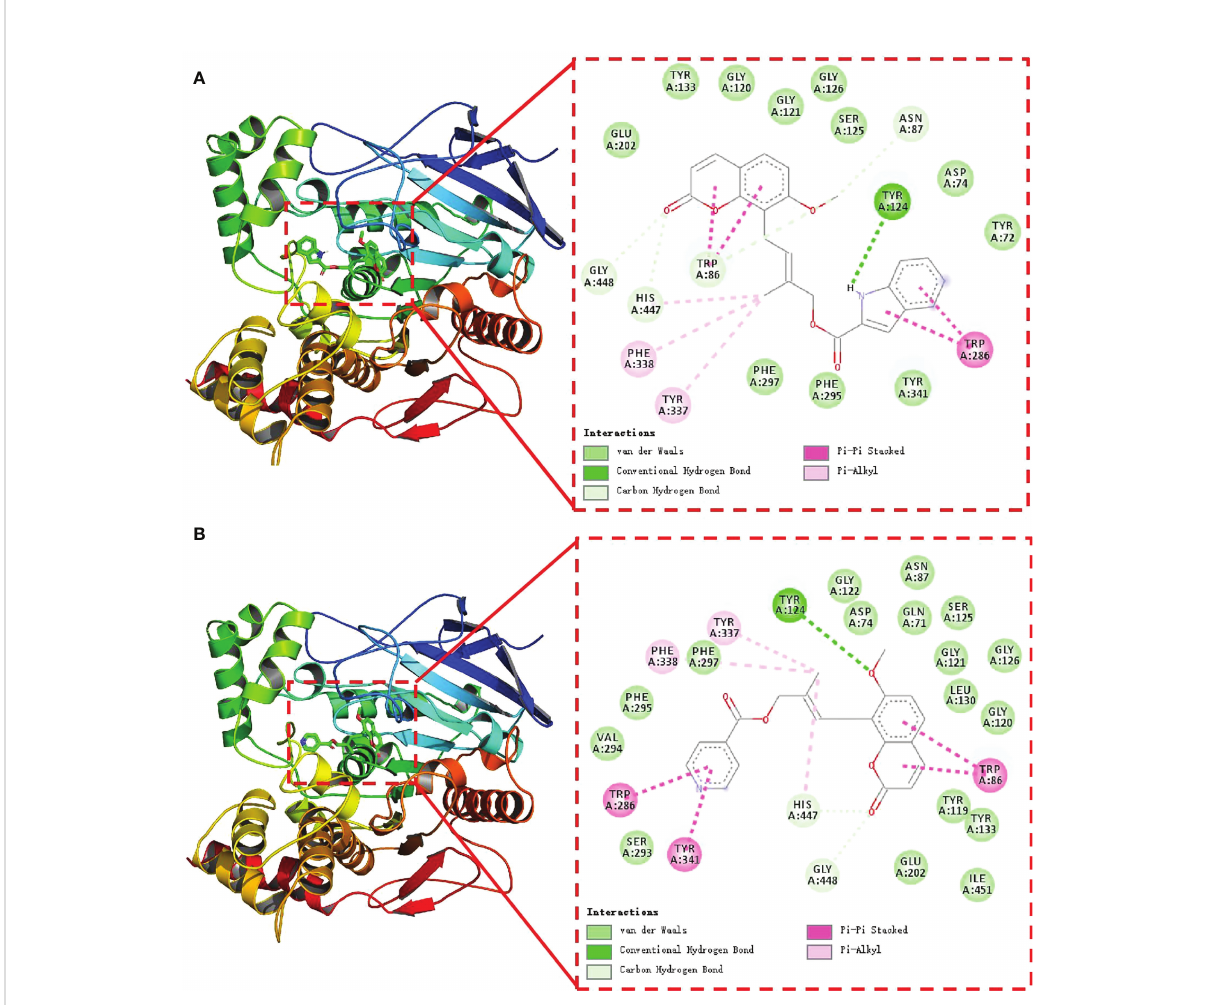
FIGURE 3 Docking pose of compound 4m (A) and 4o (B) inside AChE (the green dotted lines show the hydrogen bonds, the pink full lines show the p – p